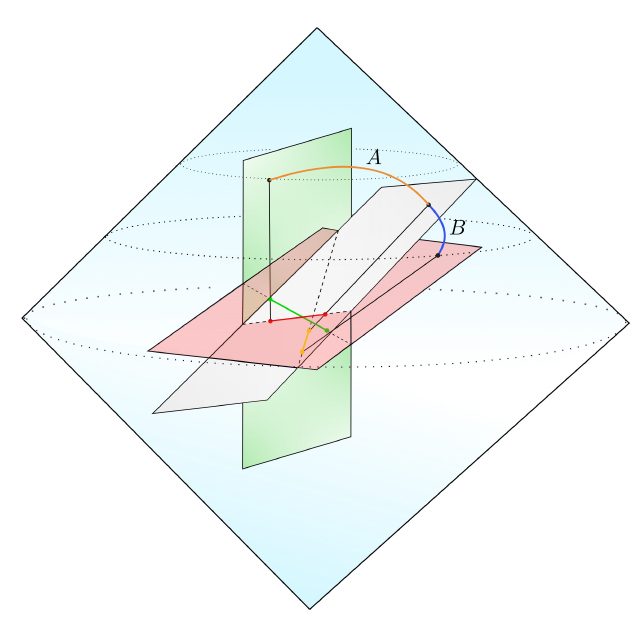
Figure 2: Holographic construction for the computation of the entanglement negativ- ity for two Galilean boosted adjacent intervals A = ( x geodesics anchored on different subsystems are shown in: red - L extr